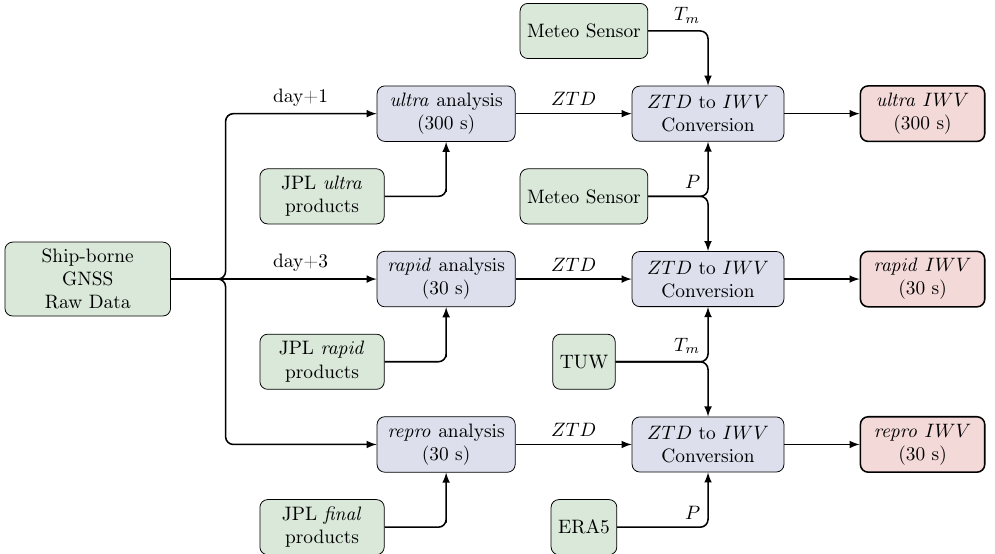
Figure 4 summarised the retrieval procedure from GNSS raw data to IWV.